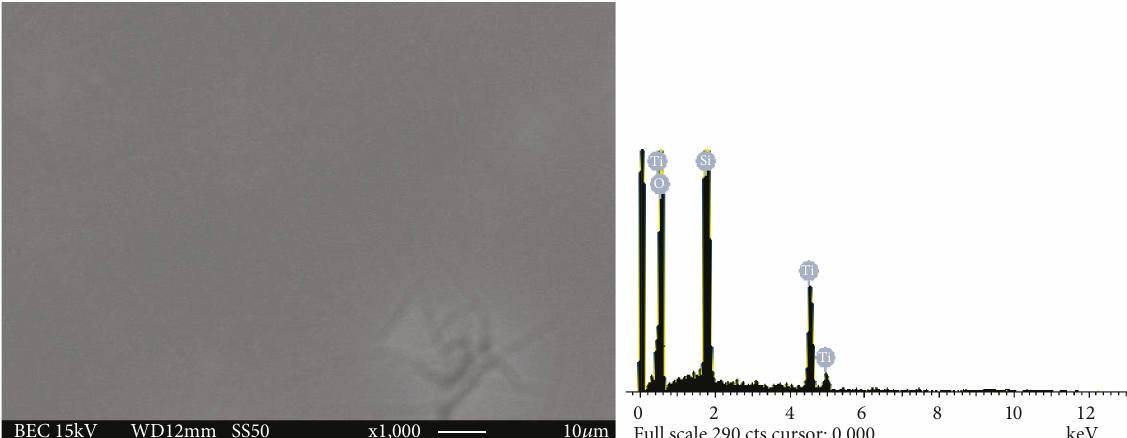
fi lm morphology obtained after 3 treatment cycles using a stirring plate and half an hour of immersion. Figure 5: SEM image of TiO 2